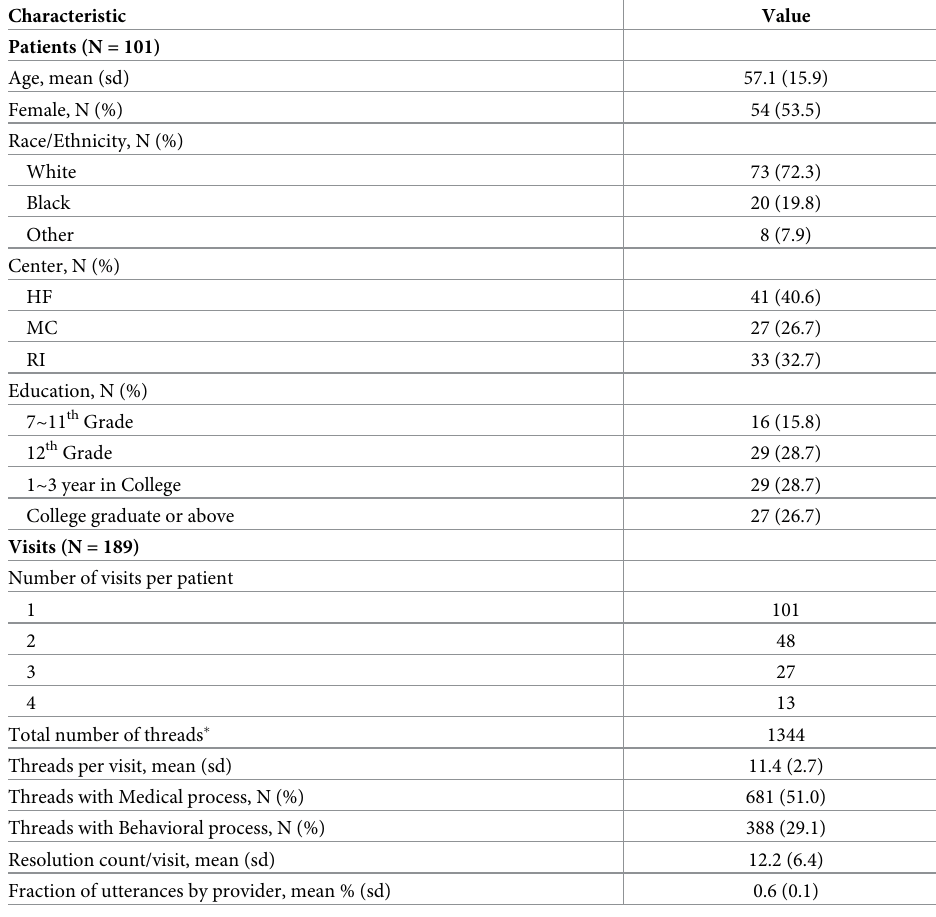
Table 1. Patient and visit